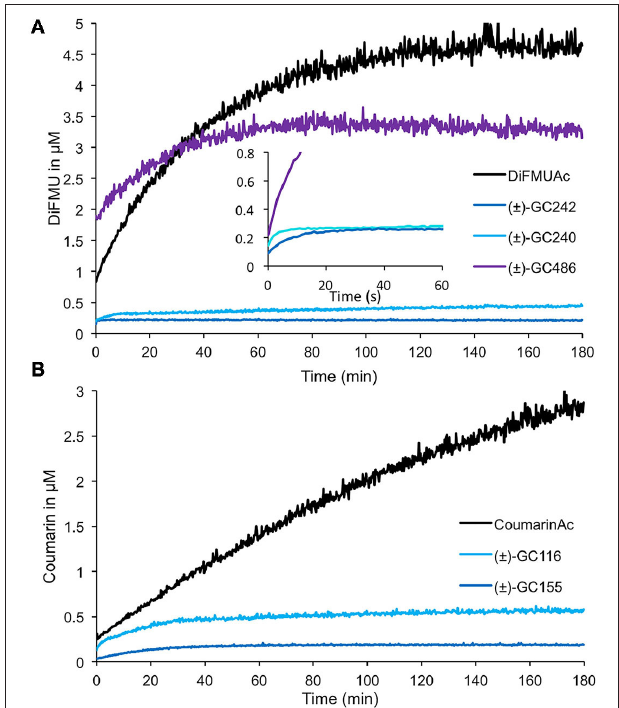
FIGURE 8 | Enzymatic assays with profluorescent probes harboring various D-ring moieties or acetate groups. Progress curves during DiFMU (A) and Coumarin (B) profluorescent probes at 10 µ M cleavage with RMS3 protein at 400nM monitored ( λ em : 460nm) at 25 ◦ C. These traces represent one of the three replicates, and the experiments were repeated at least two times.